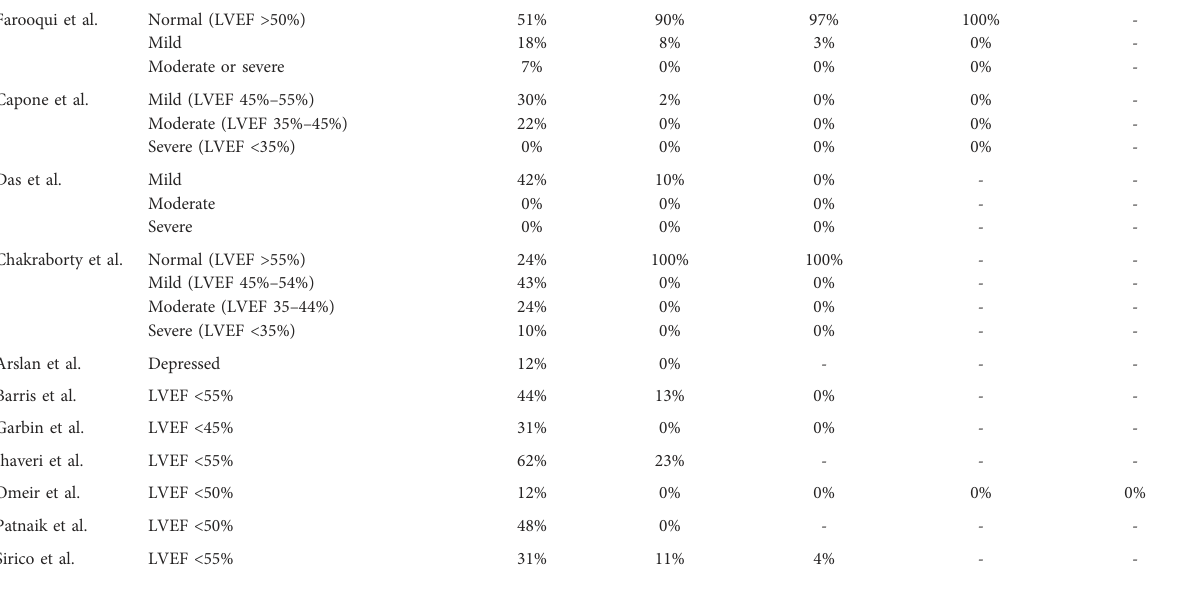
TABLE 2 Left ventricular ejection fraction (LVEF)